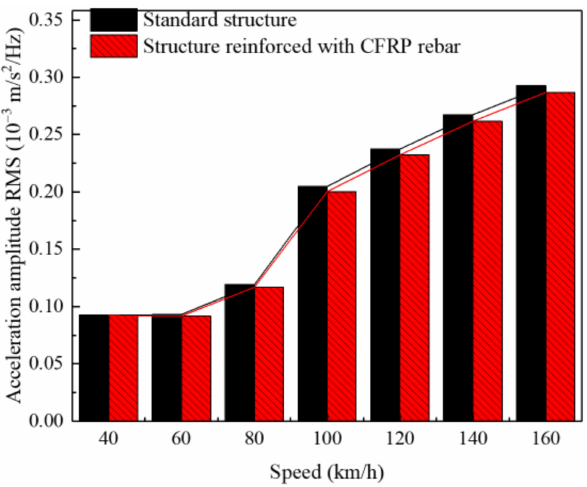
Figure 21. Spectrum of the vibration amplitude at point B. ( a ) Acceleration amplitude-frequency for the standard structure; ( b ) acceleration amplitude-frequency for the structure reinforced with CFRP rebars.